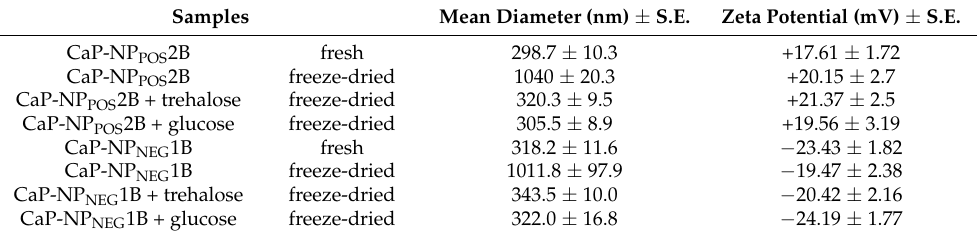
Table 6. Mean diameters and Zeta potential values of fresh and freeze-dried samples.